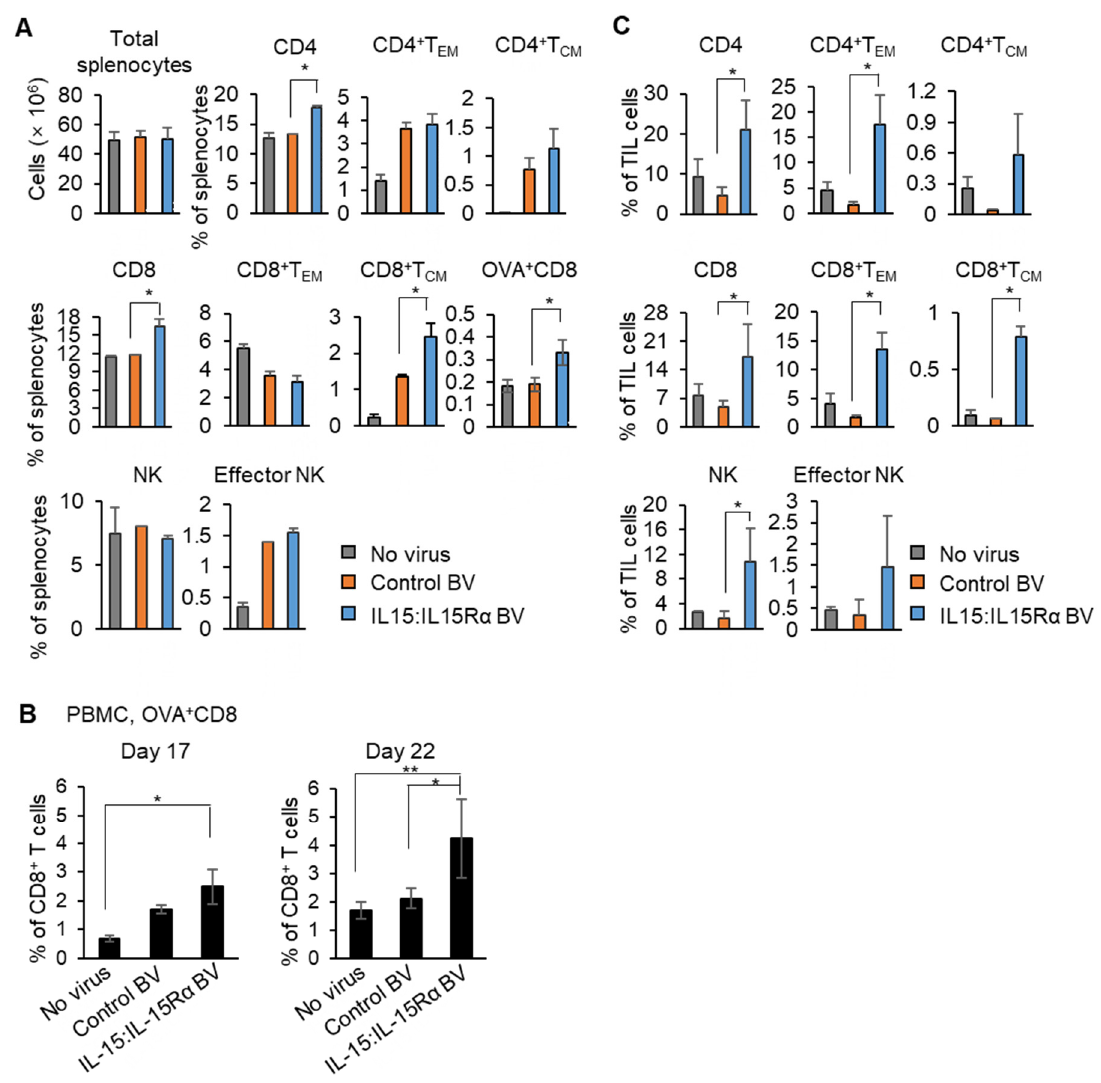
Figure 4. The BacMam-based IL-15:IL-15R α -B16F10-OVA vaccine induced strong tumor antigen-specific T cell and NK cell responses in mice. ( A – C ) The mice were immunized with IL-15:IL-15R α -B16F10-OVA (IL-15:IL-15R α BV), control- B16F10-OVA (control BV), or no virus-infected B16F10-OVA (no virus), as shown in Figure 3A ( n = 4~5) and challenged with live B16F10-OVA cells. ( A ) Splenocytes were collected at day 22 and stained to analyze for the percentage of effector memory T cells (T EM , CD44 + CD62L – ), central memory T cells (T CM , CD44 + CD62 + ), OVA-specific CD8 + T cells (H-2K b /OVA (SIINFEKL)-Tetramer + CD3 + CD8 + ), and the NK subset (total NK cells; CD49b + , effector NK; CD49b + CD11b +